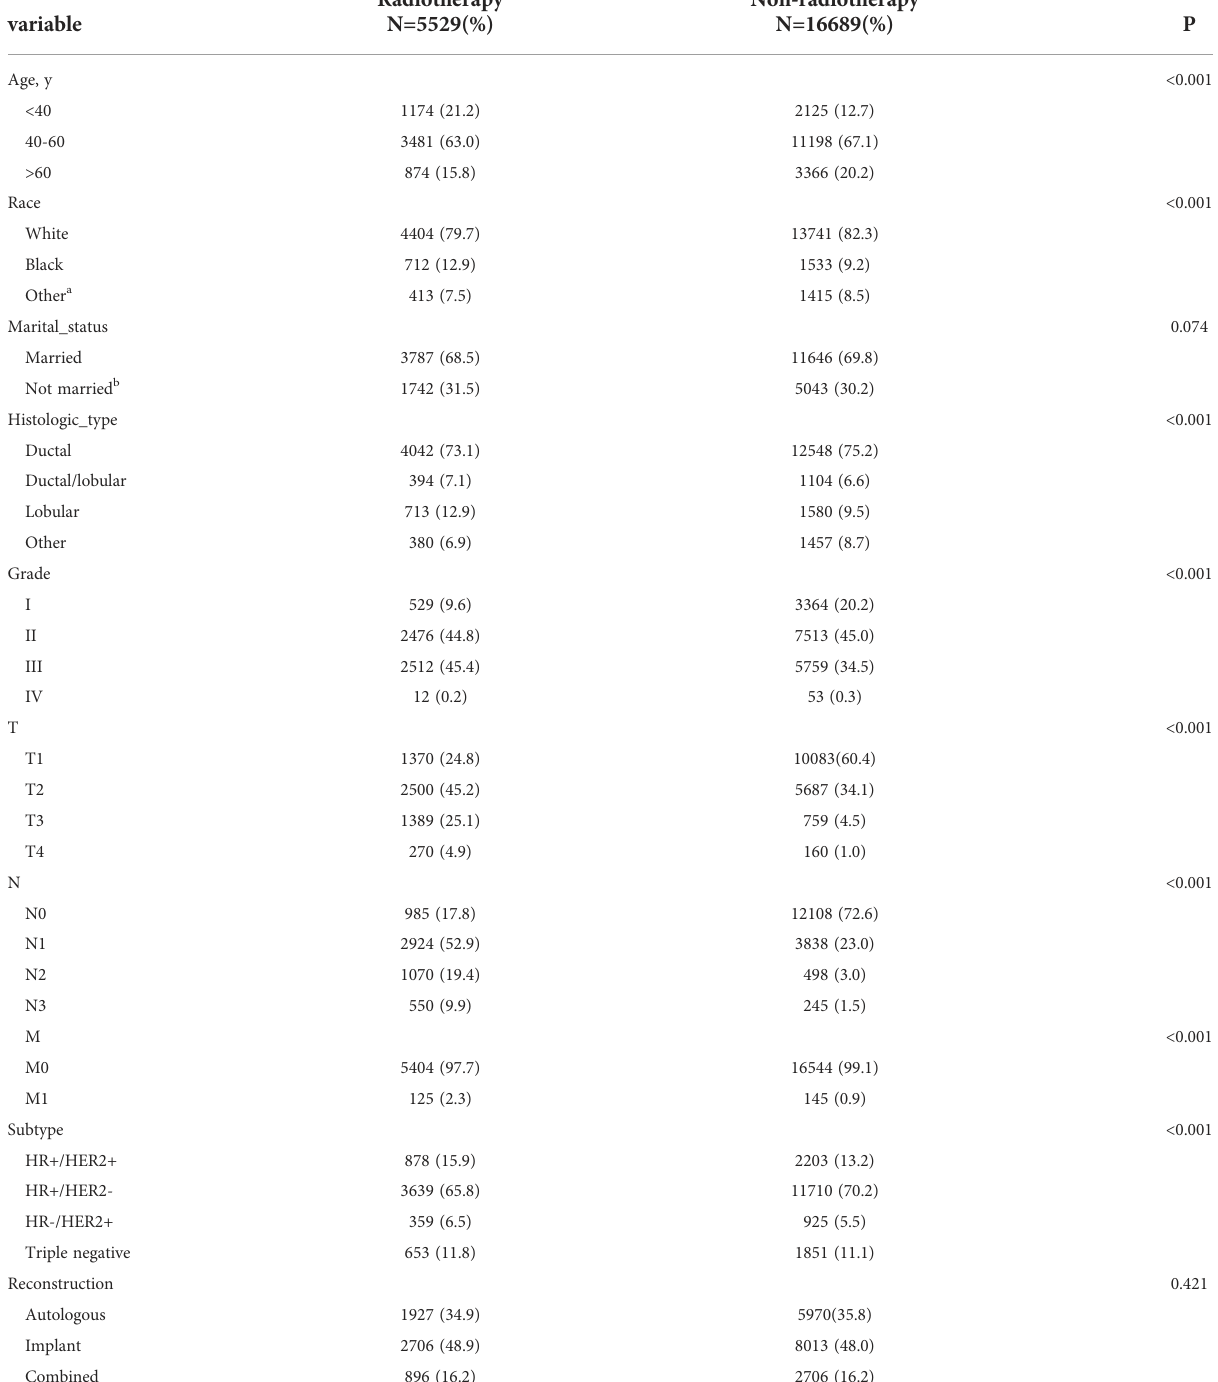
TABLE 1 Baseline demographic characteristics of patients who were reconstructed